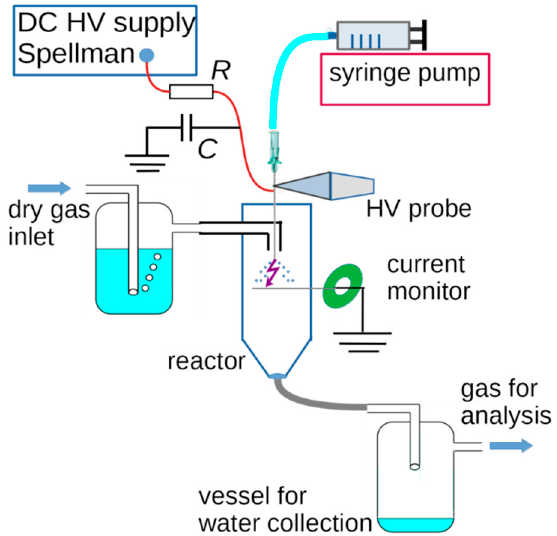
Figure 1. Simplified schematic of the experimental setup of one-stage system (1SS), with a single reactor enabling simultaneous TS and ES generation; R —resistor, C —capacitor, HV—high voltage. The treated air was either dry synthetic air (99.999% purity, Messer Tatragas, Bratislava, Slovakia), or humidified synthetic air. In addition, dry and humidified O 2 (99.95% purity, Linde Gas, Bratislava, Slovakia) were used in two comparative experiments. In order to moisturize the gas, the dry air was bubbled through a bubbler filled with deionised (DI) water (with conductivity < 3 µ S/cm). Typically, the relative humidity around 94–96% was achieved, verified by humidity sensor. The gas flow rate 1.1 L/min was constant in all experiments, controlled by rotameters Aalborg. We also performed additional comparative experiments in 1SS focused on NO and NO 2 solvation to ES water microdroplets without discharge. For this purpose, as well as for calibration of spectrometers, two special pressure tanks with calibration gases were used: one with 2000 ppm of NO in N 2 , the second one with 1000 ppm of NO 2 in synthetic air. Lower concentration of NO and NO 2 was achieved by mixing of gases from these bottles with N 2 or synthetic air, respectively. More specific description of the used discharge and individual components of our experimental setups